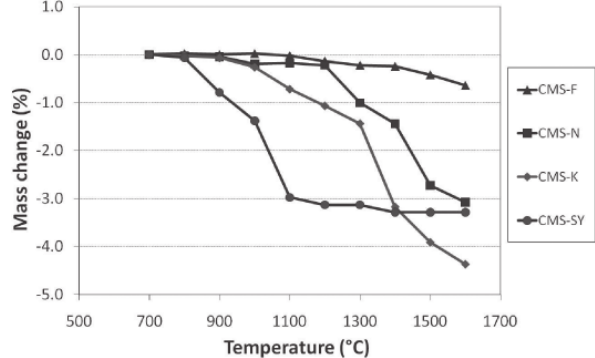
Fig. 2: Comparison of apparent viscosity of slags containing different fluidisers.